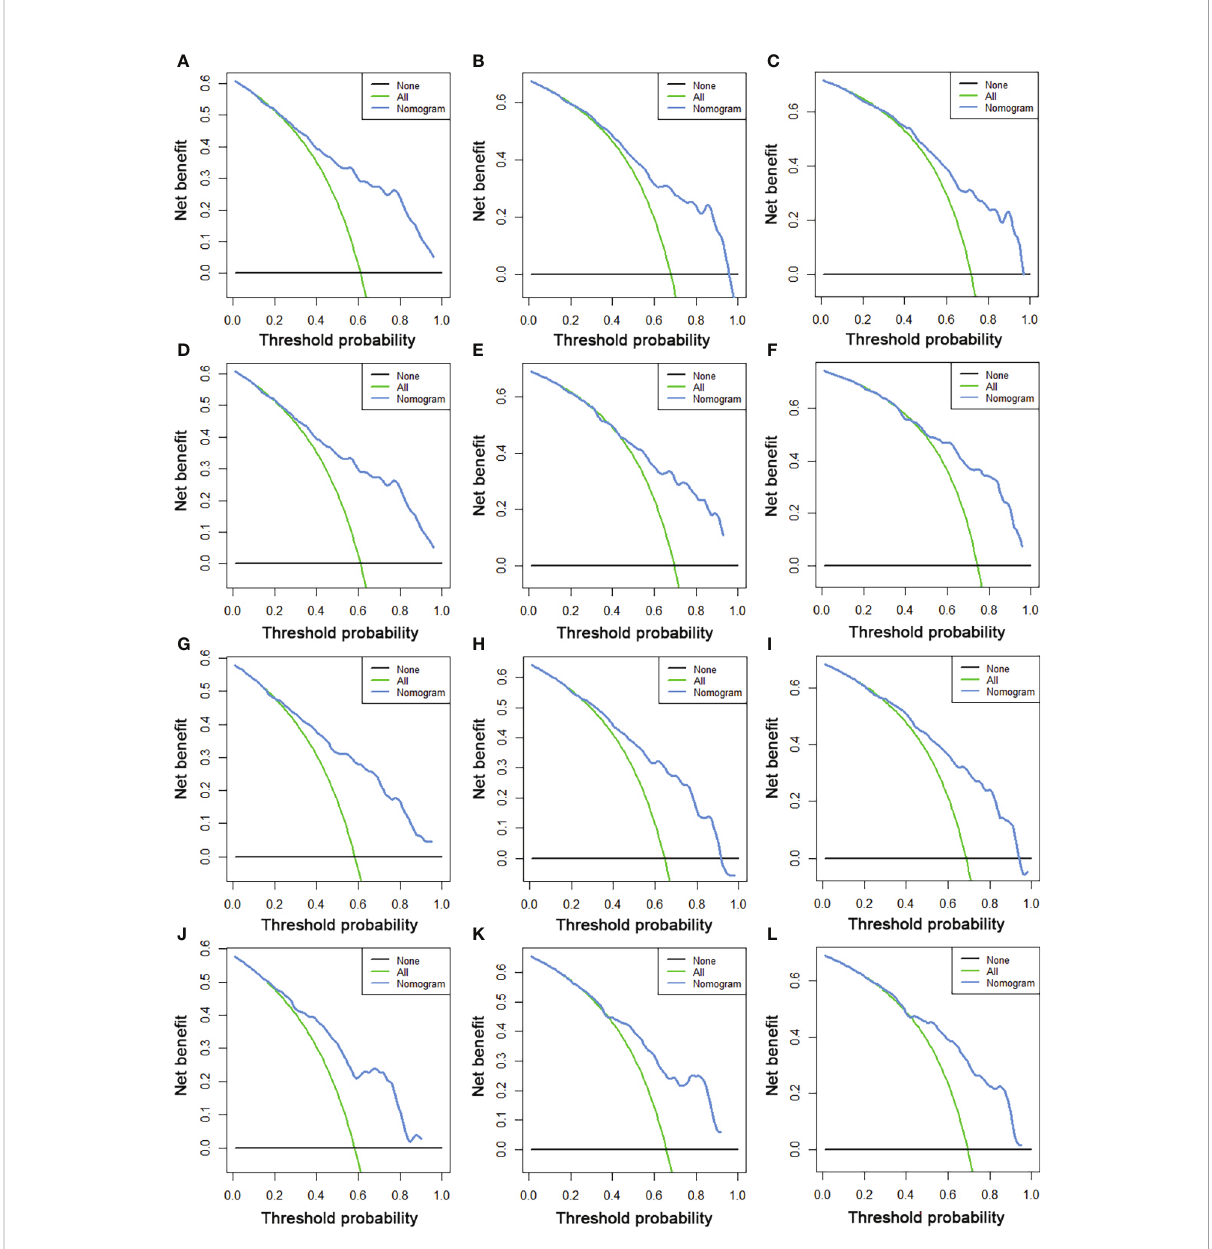
FIGURE 11 The DCA curves of 24- (A) , 36- (B) , and 48-month (C) OS in the training set and 24- (D) , 36- (E) , and 48-month (F) OS in the testing set. The DCA curves of 24- (G) , 36- (H) , and 48-month (I) CSS in the training set and 24- (J) , 36- (K) , and 48-month (L) CSS in the testing